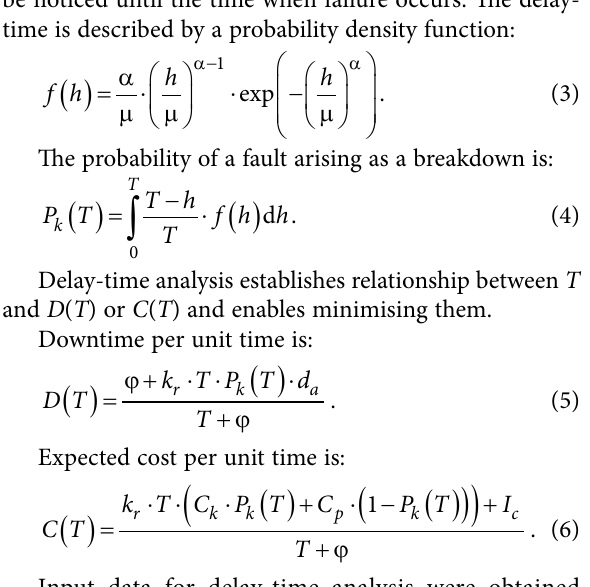
Table 1. Quality of inspection and damage intensity associated with inspection interval and useful service life Damage